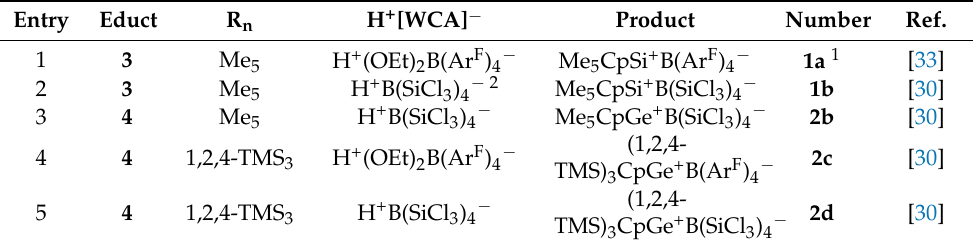
Table 1. Synthesis of catalysts 1 and 2 by selective protonation of tetrelocenes 3 and 4 .